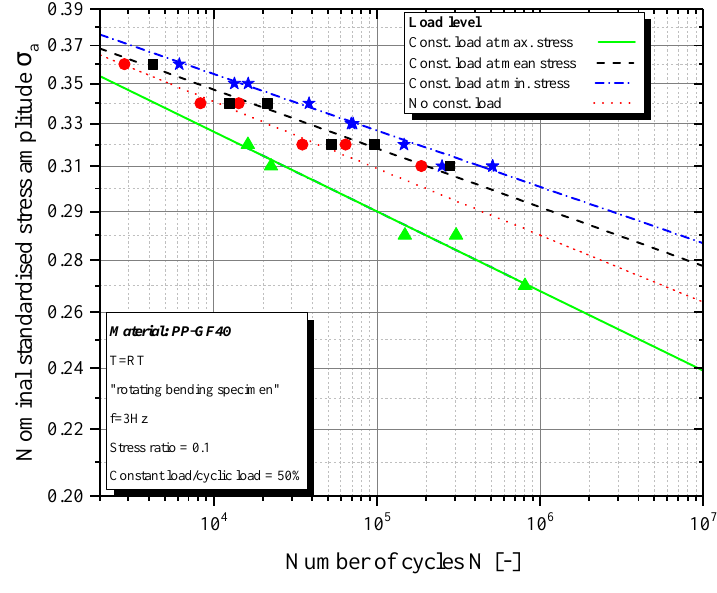
Figure 4. S/N-Curvefor various stress levels and 50% creep share.